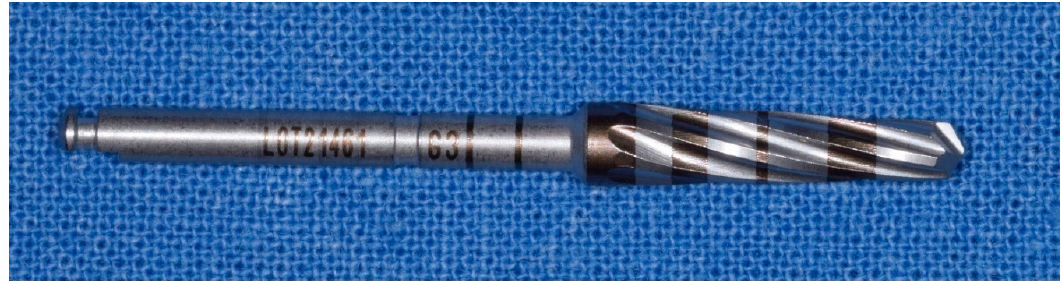
Figure 8. Fourth cutter with a diameter of 2.5 mm in the method “implant drilling with bone compaction instrumentation technique.”